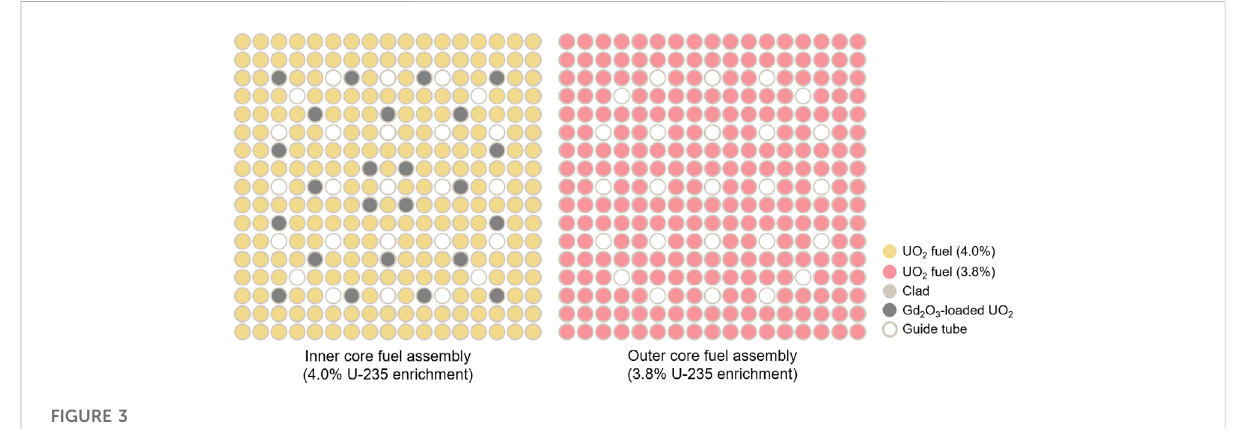
FIGURE 3 Detailed con fi guration of fuel assemblies.